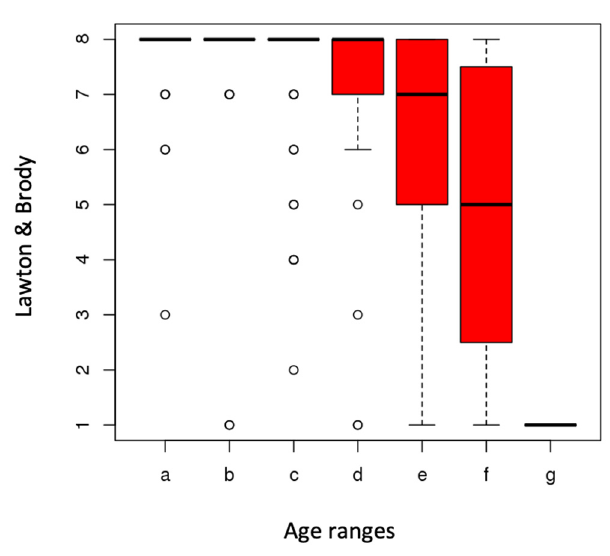
Figure 2. Relationship between Barthel and age ranges.